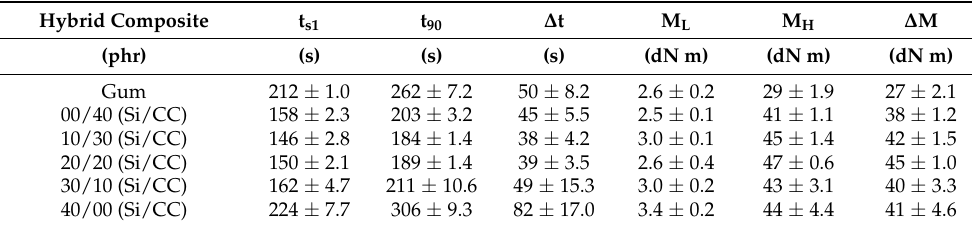
Table 4. Rheometric properties (with 1° of disk oscillation and isotherms at 150 °C) of the hybrid composites of NR with silica (SiO 2 + Si69 ® ) and calcium carbonate (CaCO 3 ) treated with 2% Chart- well ® . Gum was included as a reference point.